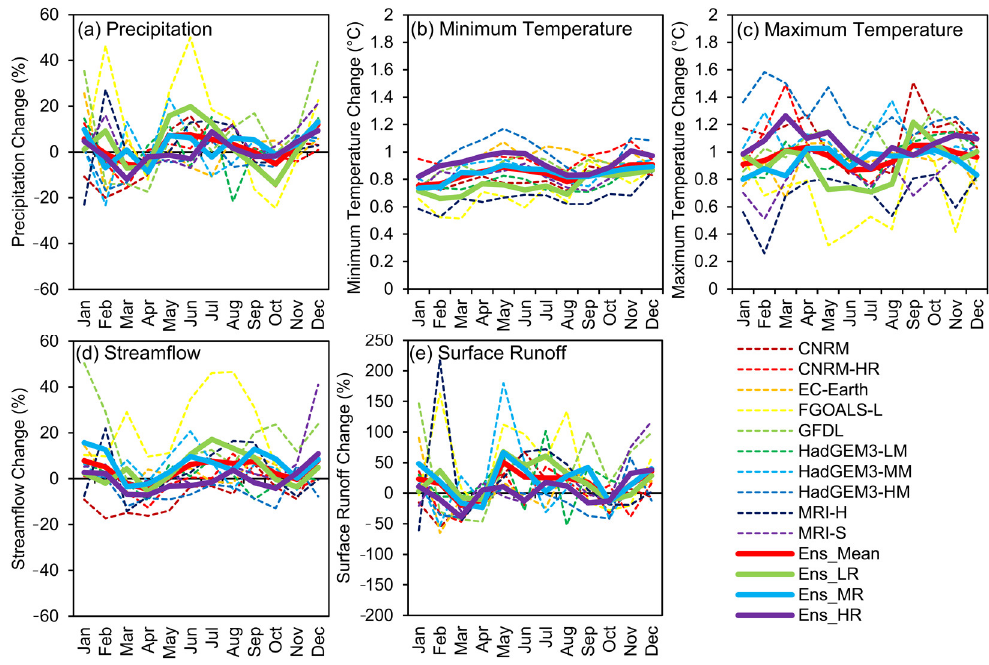
Figure 5. Changes in monthly ( a ) precipitation, ( b ) minimum temperature, ( c ) maximum temperature, ( d ) streamflow at Rantau Panjang station and ( e ) surface runoff of the Johor River Basin under the CMIP6 HighResMIP projections between 2021–2050 and 1985–2014.